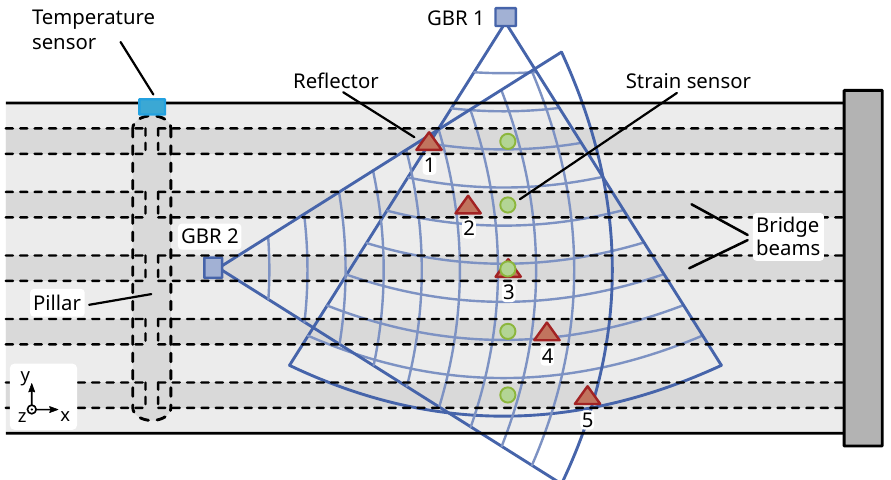
Figure 4. Vertical view of the bridge with sensor and reflector